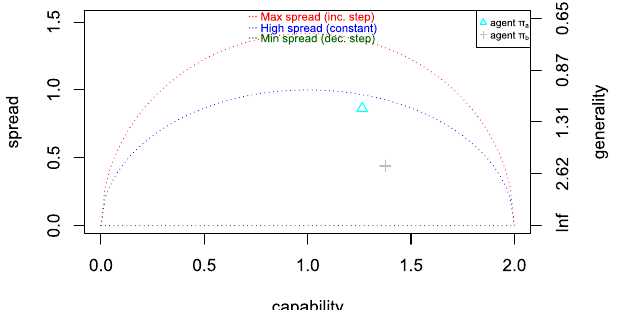
Figure 3. Representation of the two individuals in Fig. 1 in the space of spread versus capability. As spread is reciprocal to absolute generality, the lower the point the more general. The isometrics (dotted lines) represent 1 , flat at the bottom, in green), the isometrics for a constant ACC the maximum normalised generality ( γ = 0 , in blue) and the isometrics for minimum normalised generality ( γ 1 , top, in ( γ = = −